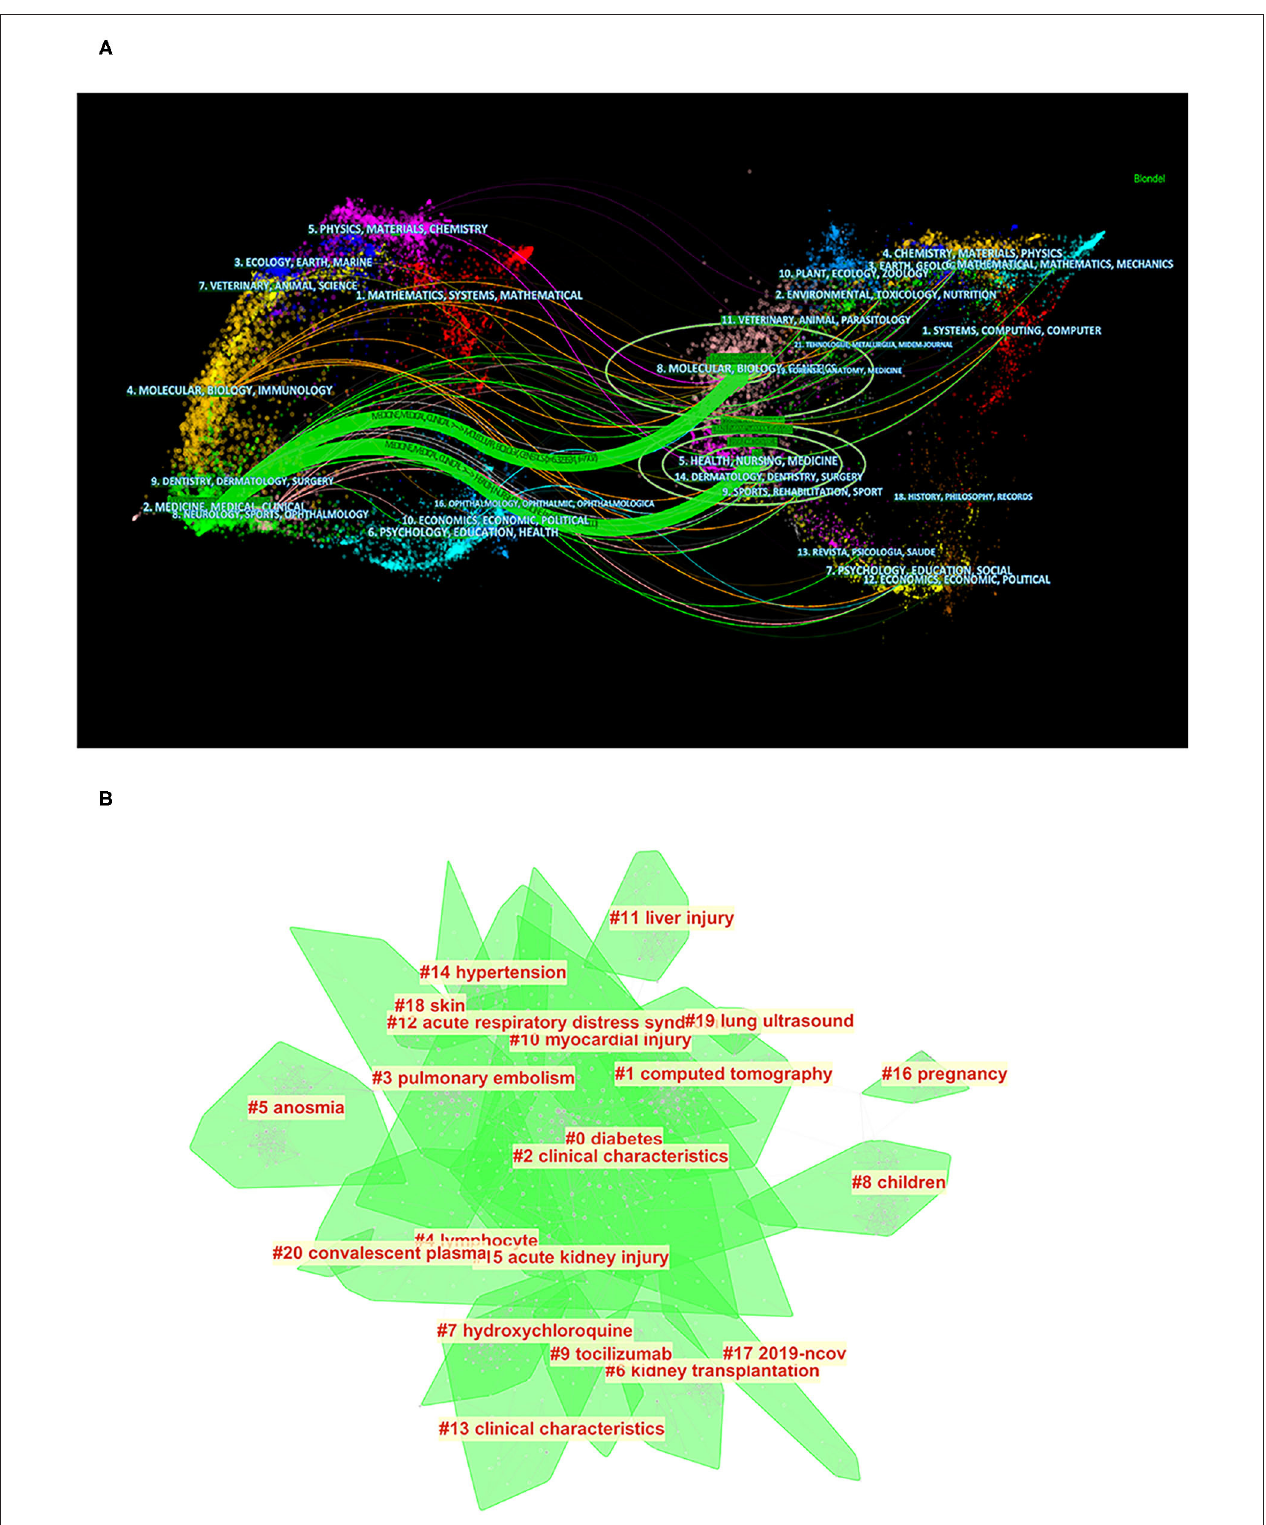
FIGURE 6 | Bibliometric analysis of the clustering of types of articles and keywords. (A) Clustering analysis of articles being cited and articles that cited literature (distribution of cited literature and journals on the left and articles that cited literature on the right). (B) Clustering analysis of keywords (the order is from 0 to 20; the smaller the number, the more keywords the cluster contains, and therefore the more attention it receives).